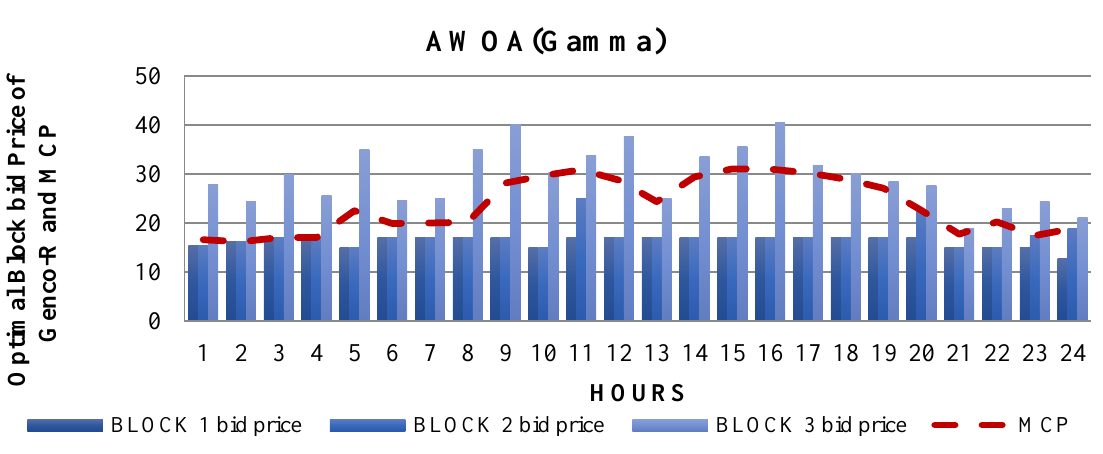
Figure 15. AWOA (Gamma Distribution Block Bid Price and MCP.